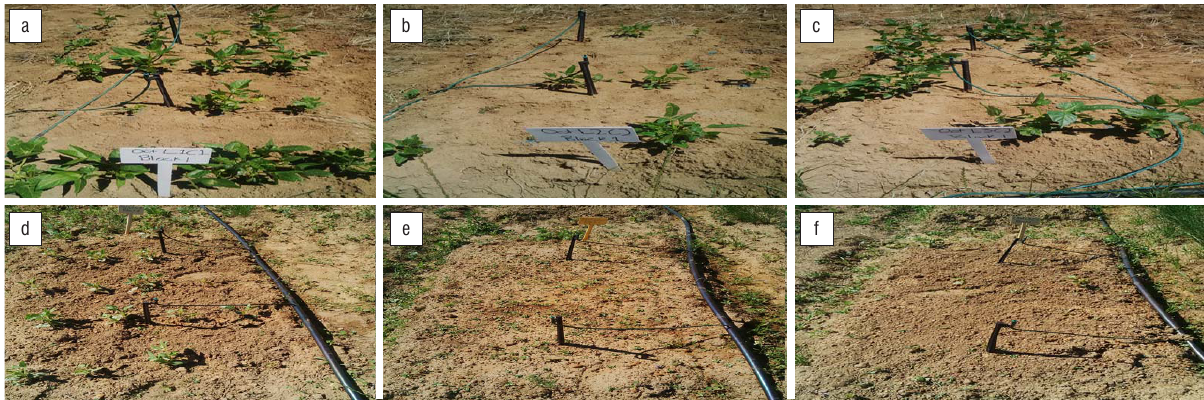
LSD , least significant difference; L1, Veg1; L2, M217; L3, Qukawa; T1, 0% Zn; T2, Zn at 50%; T3, Zn at 100%. 0.05 Means with different superscript letters within the same column are significantly different ( p <0.05).